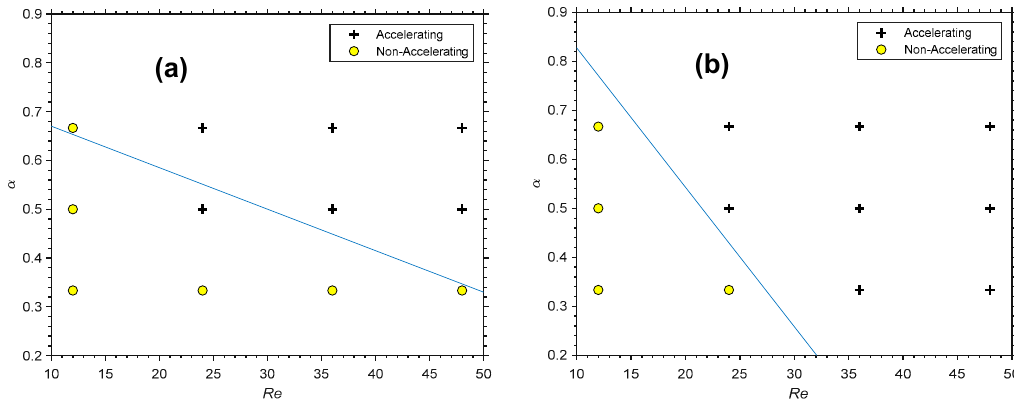
Figure 17. The 𝛼 − Re burning regime diagram for Θ = 8 ( a ) and Θ = 10 ( b ). Figure 17. The α − Re burning regime diagram for Θ = 8 ( a ) and Θ = 10 ( b